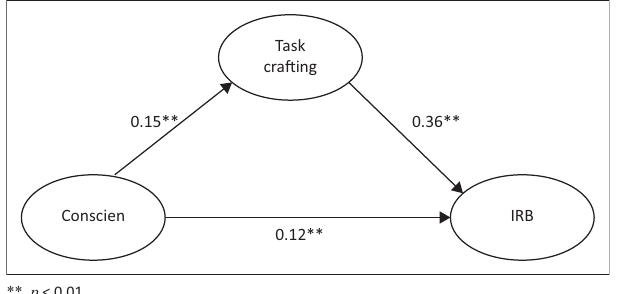
FIGURE 4: Path diagram between conscientiousness, task crafting and in-role behaviour.